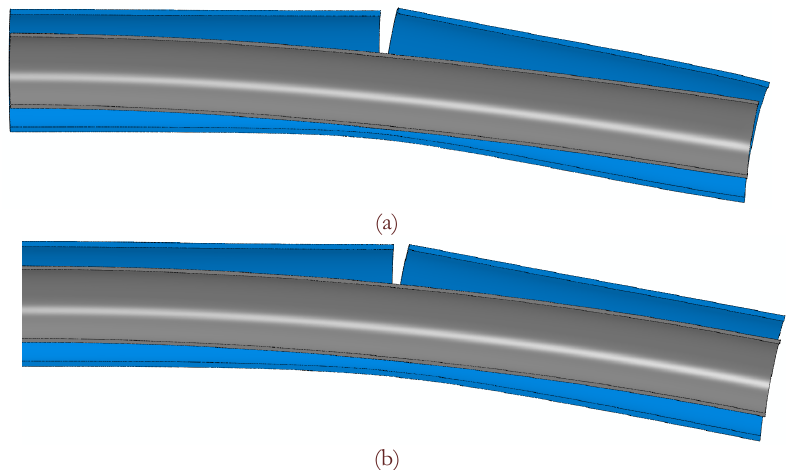
Figure 3: Effect of distributing (a) and kinematic (b)